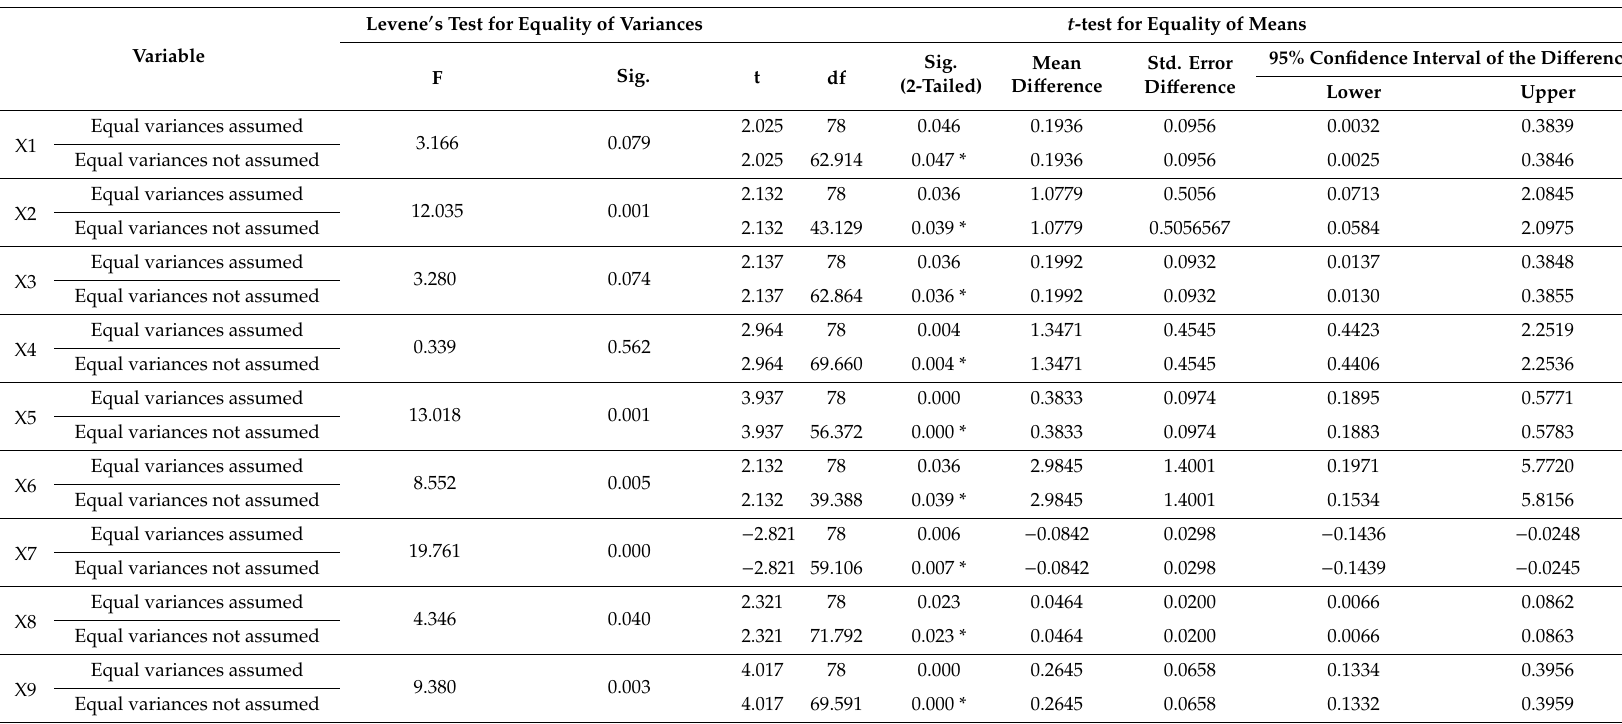
Table 2. Results from Levene’s test and the Students’ t -test for the learning set. The statistically significant results from the Student’s t -test are denoted with an asterisk. Levene (cid:48) s Test for Equality of Variable